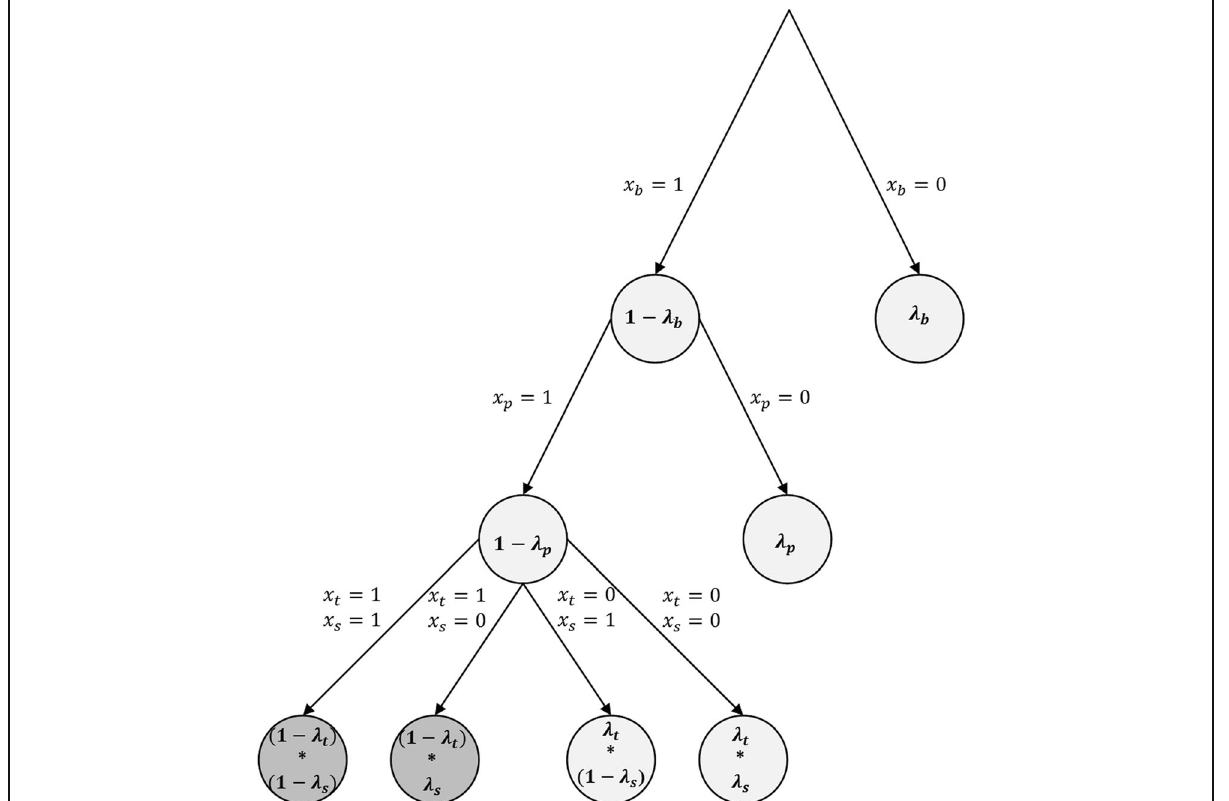
Fig. 2 SN states: the paths from the top node to a bottom node correspond to the SN states with non-zero probability. The probability of a path, i.e., the probability of a state, is the product of the probabilities in the associated transitions. The SN states corresponding to the relay mode and the on mode are both marked by a dark shade of